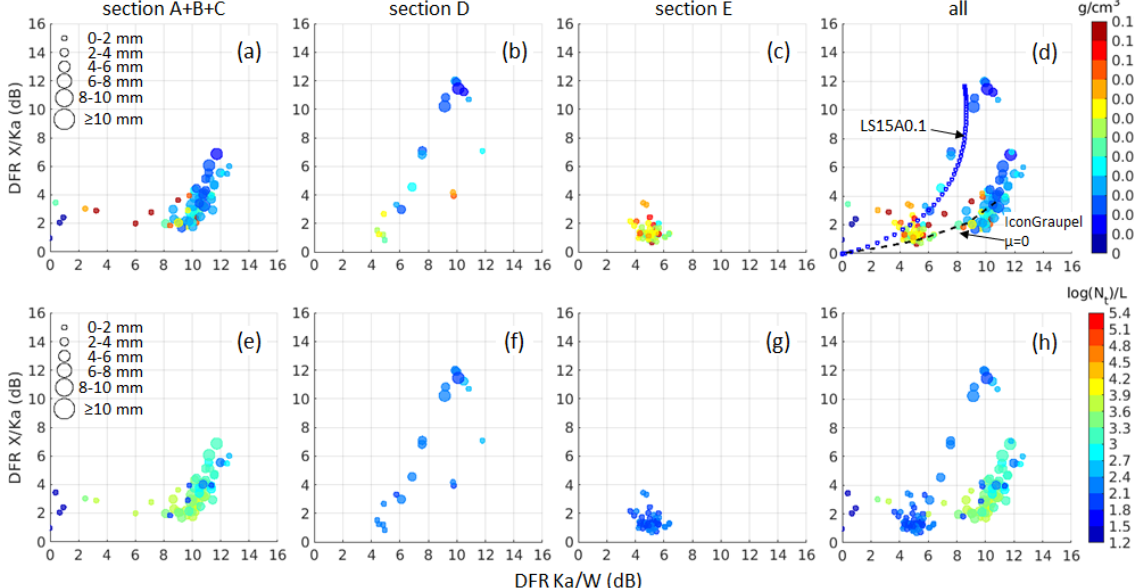
Figure 11. DFR scatterplots for the 19:38–20:00UTC segment during the November 22 flight. Data points are colored by the effective bulk density ( ρ e ) (a–d) and by the total concentration ( N t ) (e–h) . The dot size is proportional to the calculated MVD. In panel (d) , the blue line is for riming model A with an effective liquid water path of 0.1kgm − 2 (Leinonen and Szyrmer, 2015), and the black line is for a graupel model from Fig.